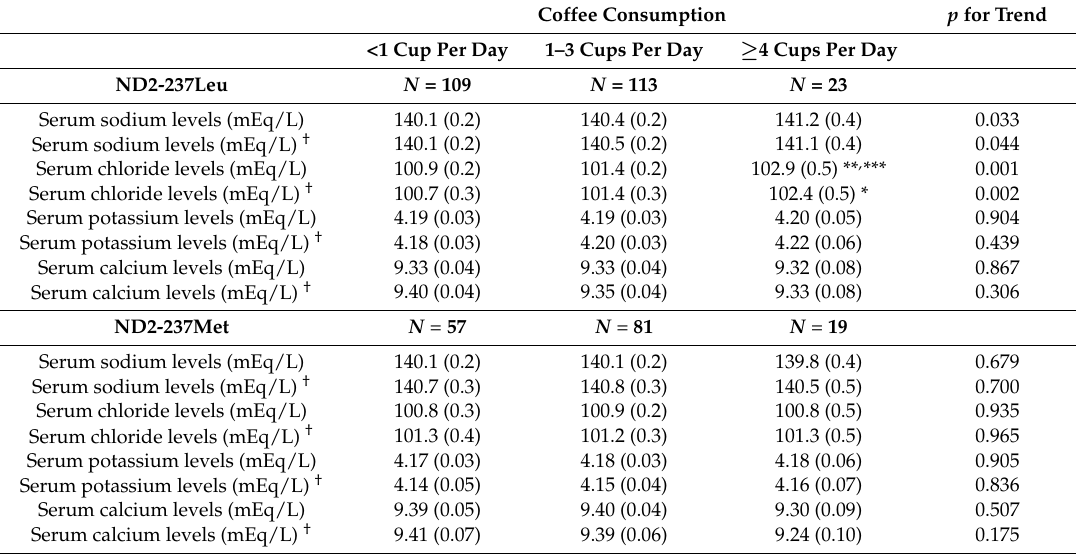
Table 2. Serum electrolyte levels by coffee consumption status and ND2-237 Leu/Met genotype. Coffee